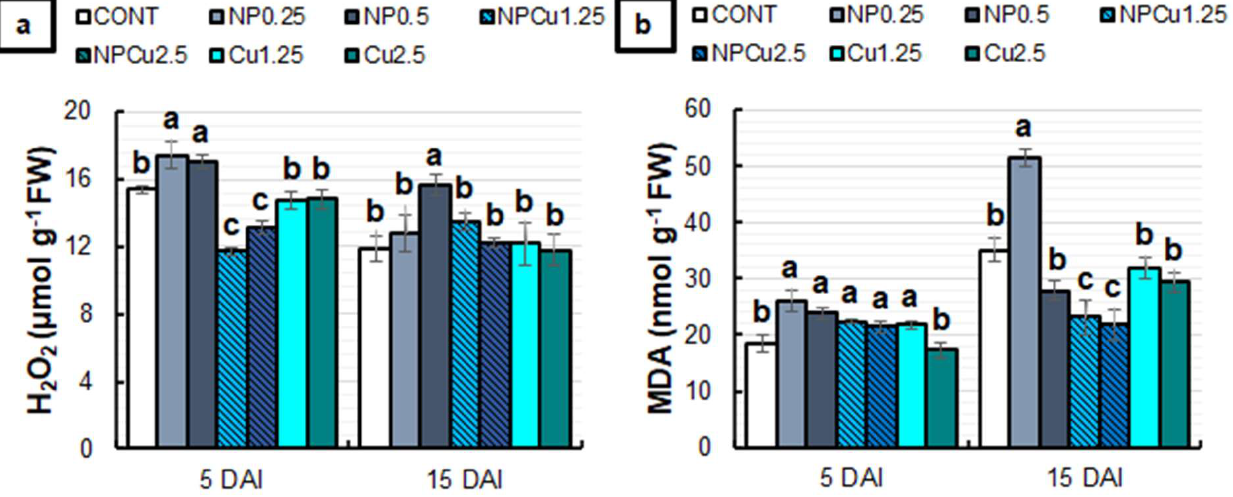
Figure 6. Hydrogen peroxide (H 2 O 2 ) ( a ) and malondialdehyde (MDA) ( b ) content of leaf discs of Coffea arabica cv. IPR 100 at 5 and 15 days after infection (DAI) with H. vastatrix . Before infection, the discs were treated with distilled water as a control (CONT), chitosan nanoparticles without Cu 2+ ions (NP), chitosan nanoparticles containing Cu 2+ ions (NPCu), and free Cu 2+ ions (Cu). The formulations were diluted in distilled water, obtaining the corresponding concentrations of chitosan (CS) in NP and NPCu treatments (0.25; 0.5 g L − 1 ) and of Cu 2+ ions (1.25; 2.5 mmol L − 1 ) in NPCu and Cu treatments. Results are expressed as mean ( n = 4) ± standard error. Equal letters in the columns indicate that there was no significant difference in the Scott–Knott test ( p < 0.05) at the same time point. Regarding the activity of antioxidant enzymes, only the NP treatment (0.25 g L − 1 ) induced a 27% reduction in superoxide dismutase (SOD) activity at 5 DAI. At 15 DAI, NP treatments (0.25 and 0.5 g L − 1 ) did not show significant differences compared to CONT, while NPCu and Cu treatments (1.25 and 2.5 mmol L − 1 ) induced an average increase of 22% in SOD activity (Figure 7a). At 5 DAI, all treatments differed from the CONT, showing reduced catalase (CAT) activity. At 15 DAI, there was an average reduction of 20% in CAT activity in the NPCu (1.25 mmol L − 1 ) and Cu (1.25 and 2.5 mmol L − 1 ) treatments compared to the CONT (Figure